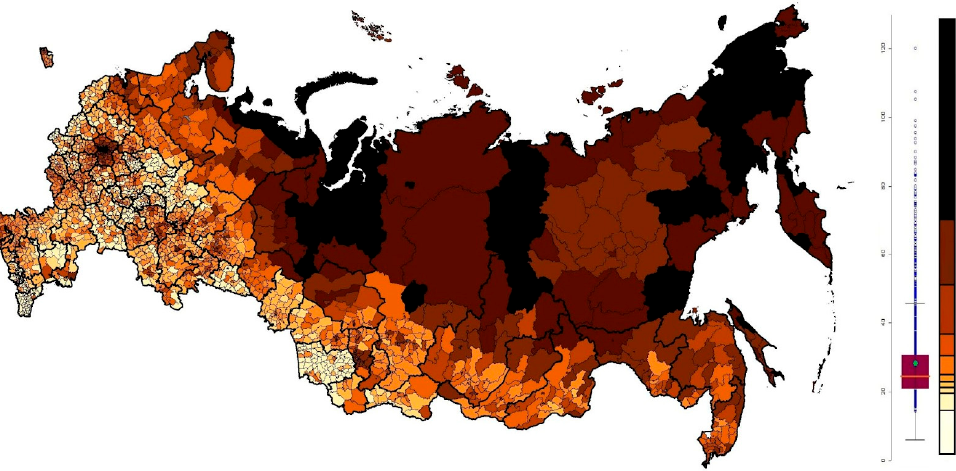
Figure 3. Natural breaks map of average nominal employees’ wages of large, medium-sized and non-profit enterprises over 2015–2019 (mln. RUB)